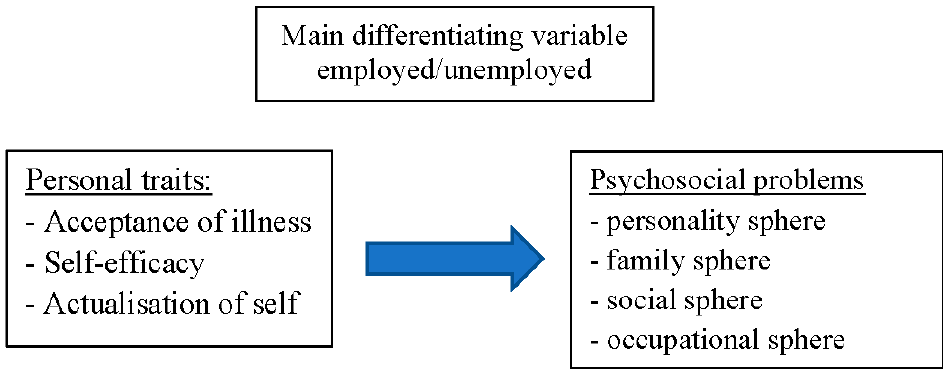
Figure 1. The theoretical design of the study.